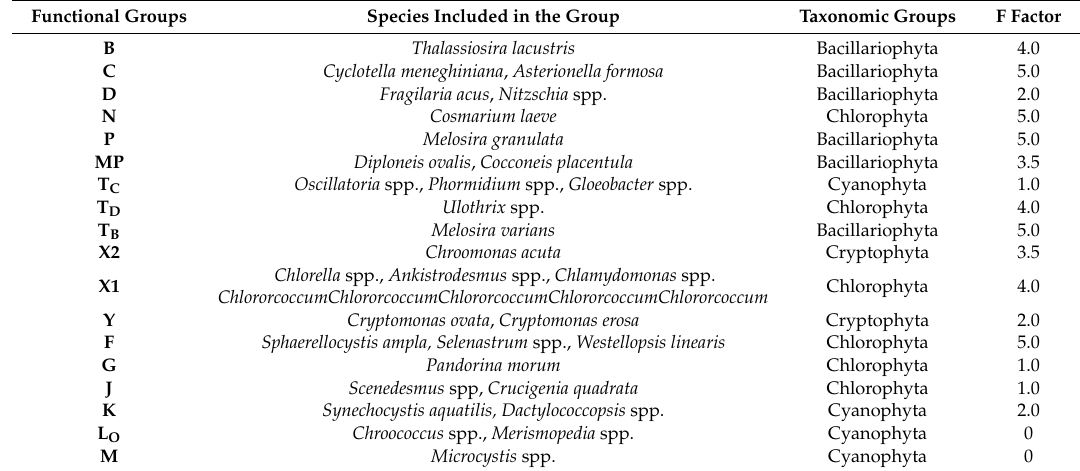
Table 4. Phytoplankton taxa and their functional and taxonomic groups in Qingcaosha Reservoir.